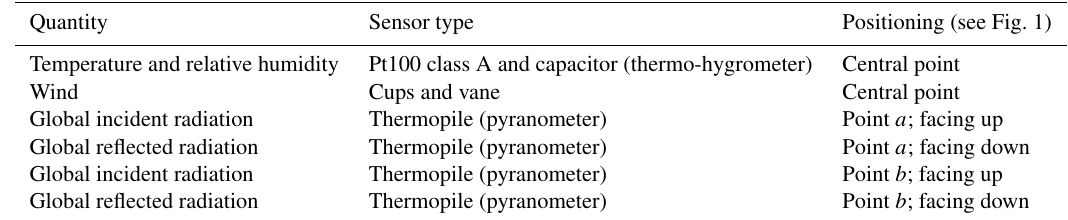
Table 2. Ancillary measurement sensors and their positioning with reference to the scheme in Fig. 1.